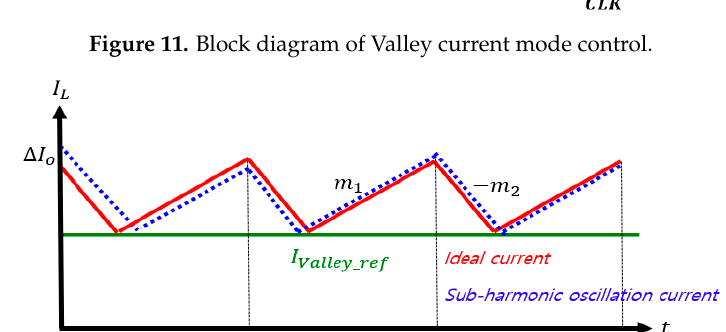
Figure 12. Inductor current that occurs when duty is above 0.5 in Valley current mode control.